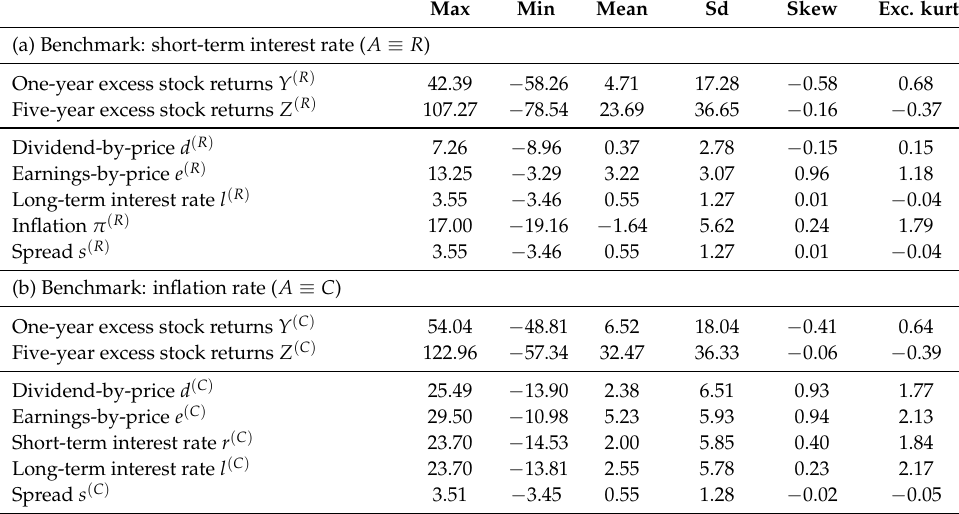
Table 2. Summary statistics of transformed variables (in percentages). Panel (a) shows the available variables transformed according to the short-term interest rate, e.g., excess returns corresponding to the risk premium. Panel (b) shows the available variables net of inflation, i.e., in real terms. l ( R ) equals s ( R ) by construction as explained in the footnote in Section 3.1.